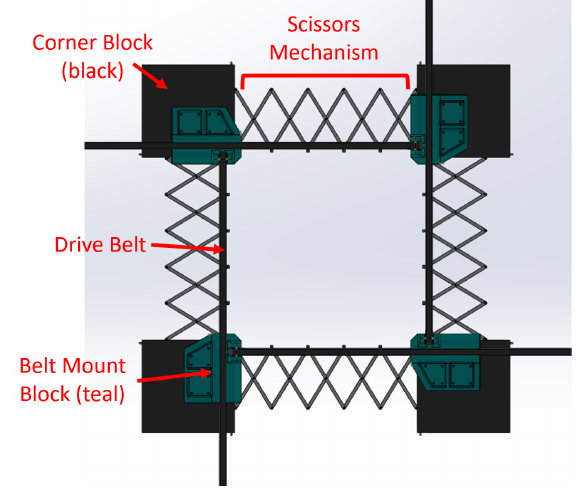
Figure 5. A drawing of the completed stretch tool is shown from above. Scissor-hinge links are 90 mm in length.